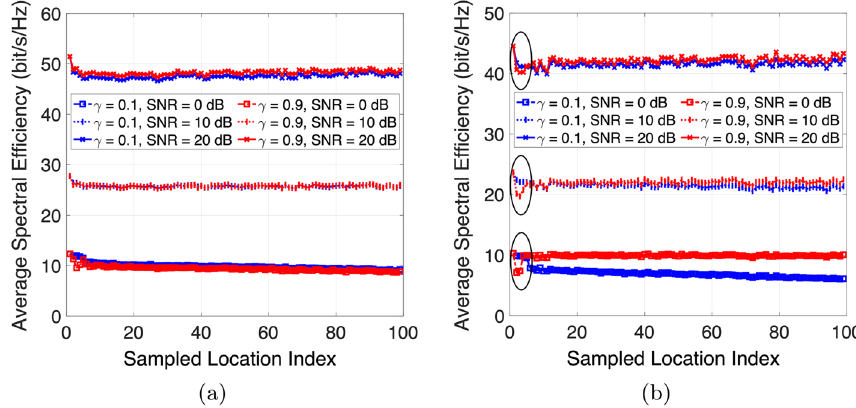
Fig. 12 Average SE per sampled location with different ̺ for DRL-SE. a ̺ = 0.1 . b ̺ = 0.5